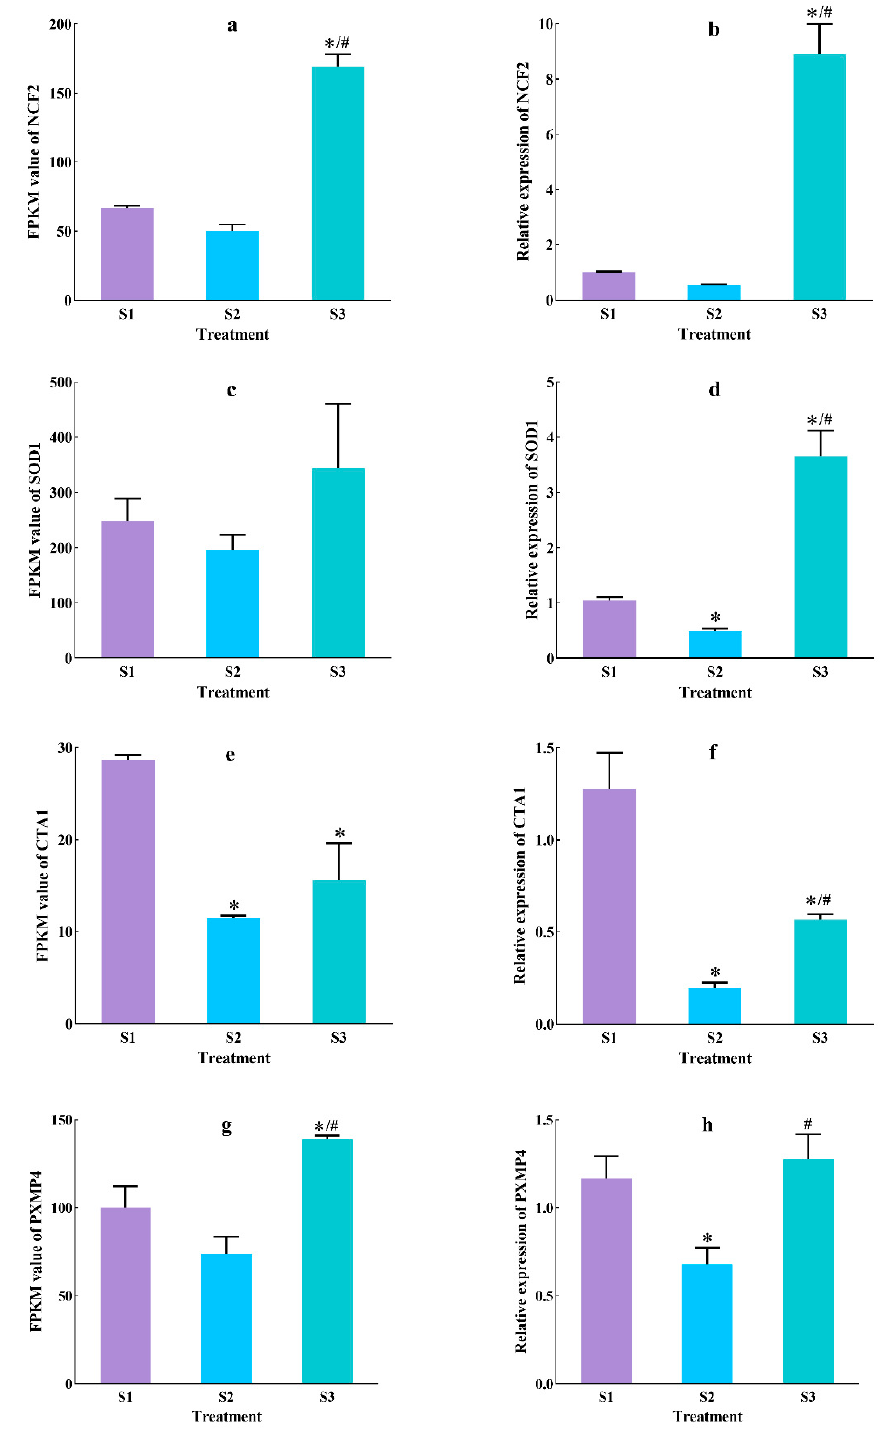
Figure 4. mRNA expression of NCF2 , SOD1 , CTA1 and PXMP4 in the F. solani colony. ( a , c , e , g ) are fragments per kilobase of exon model per million mapped fragments (FPKM) values from transcriptome sequencing data; ( b , d , f , h ) are relative expression values from RT-qPCR data. S1 group ( n = 3): inoculation of F. solani on PDA; S2 group ( n = 3): inoculation of F. solani on PDA containing 40 µ mol/L DPI; S3 group ( n = 3): inoculation of F. solani on PDA containing 40 µ mol/L DPI. On the fourth day of cultivation, 5 mL of 0.0012% H 2 O 2 was added to each dish. Data are expressed as mean ± SD. * p < 0.05 S2 or S3 vs. S1, # p < 0.05 S3 vs. S2.